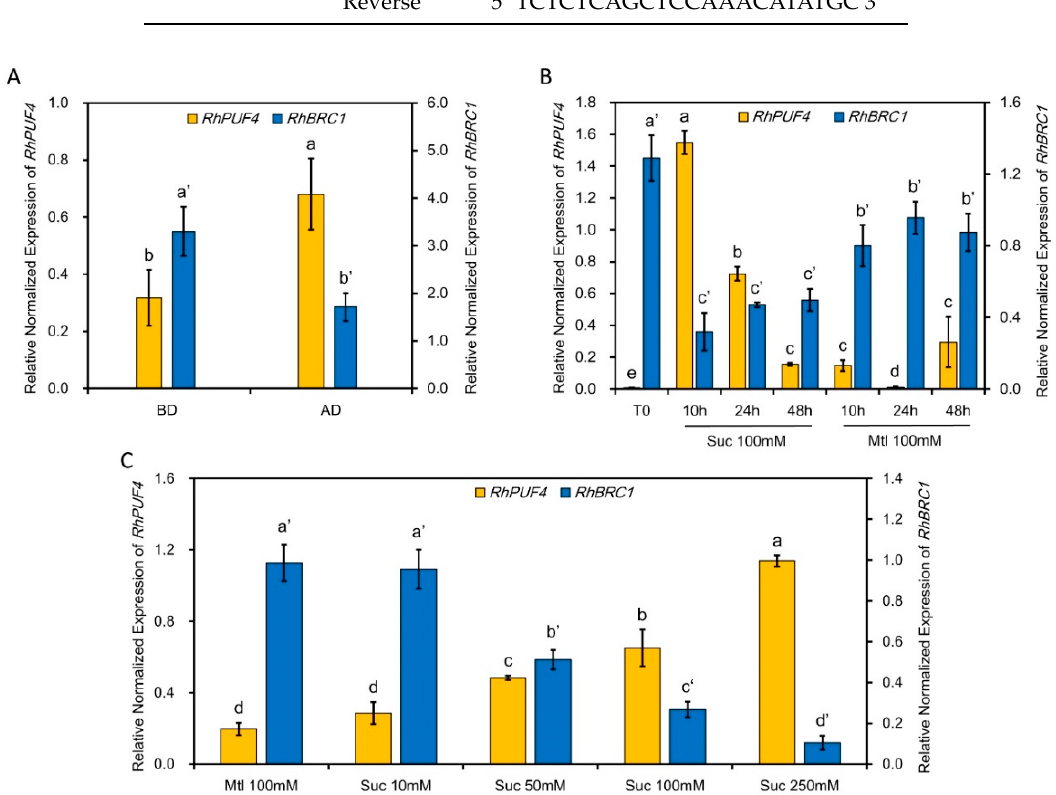
Figure 5. RhPUF4 expression is under the control of sucrose and the sucrose metabolism, and has an opposite expression pattern to RhBRC1 . ( A ) Transcription levels of RhPUF4 and RhBRC1 in buds before decapitation (BD) or after decapitation (AD); ( B ) transcription levels of RhPUF4 and RhBRC1 in in vitro -cultured buds after 0 h, 10 h, and 24 h under 100 mM of sucrose or 100 mM mannitol; ( C ) transcription levels of RhPUF4 and RhBRC1 in buds treated with different sucrose concentrations. Mtl, mannitol; Suc, sucrose. Data are means ± SEs of three replicates. The letters indicate significant differences between the different treatments with p < 0.05. Table 1. Specific PCR primers of each RhPUF member.